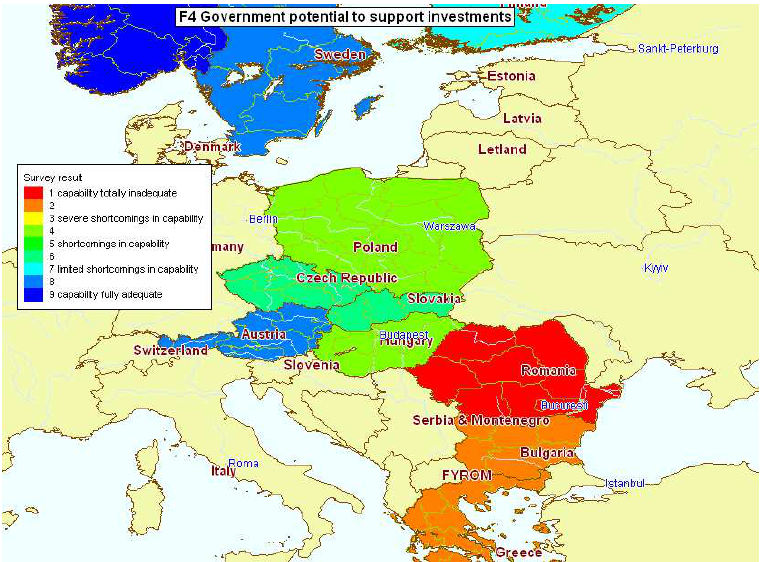
Figure 4. Thematic map for interoperability condition F4 (Government potential to support investments)